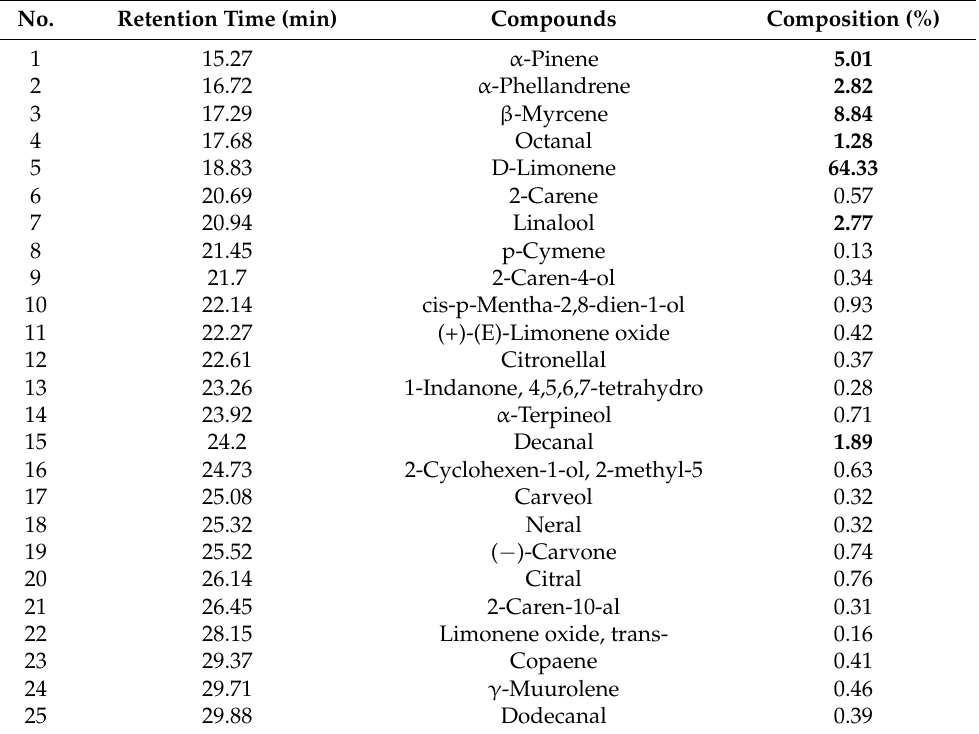
Table 1. GC-SQ-MS-analyzed chemical compounds of